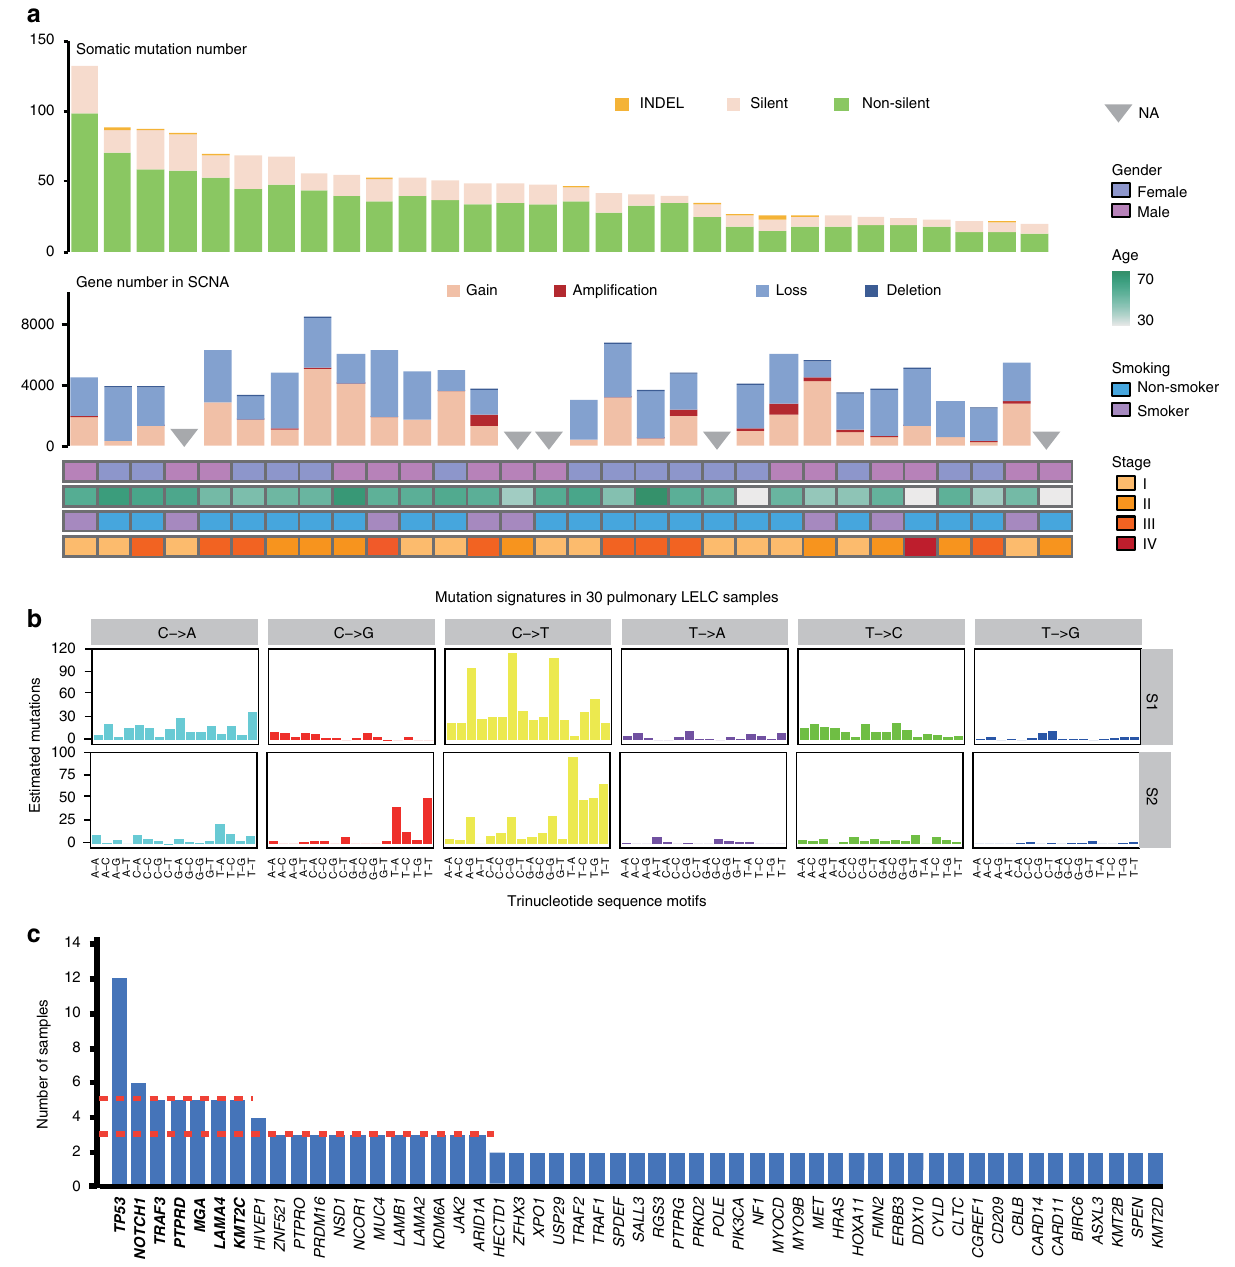
(22/46) of patients, leading to ampli fi cation of 34 cancer related genes annotated in the Catalogue of Somatic Mutations in Cancer (COSMIC) database and signaling pathways including MAPK ( q = 0.001), JAK/STAT ( q = 0.014), and cell cycle ( q = 0.032) (Supplementary Data 8). Nineteen signi fi cant focal copy number alterations (8 ampli fi cations and 11 deletions) were identi fi ed using GISTIC2 (Fig. 2a and Supplementary Data 9) 28 . Sig- ni fi cantly ampli fi ed regions included 7p11.2, 9p24.1, 11q13.3, and 12p13.2. The predominant event was ampli fi cation in 11q13.3, which contained the CCND1 gene. Ampli fi cation of CCND1 may